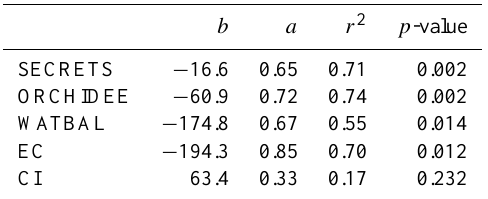
Table 5. Coefficients for the linear regression analyses between pre- cipitation (mm a − 1 ) and drainage (mm a − 1 ) for the five approaches (SECRETS, ORCHIDEE, WATBAL, eddy covariance [EC] and conservative ion [CI]). Included in the table are estimates of the co- efficient of determination ( r 2 ) and the p -values for each regression analysis.